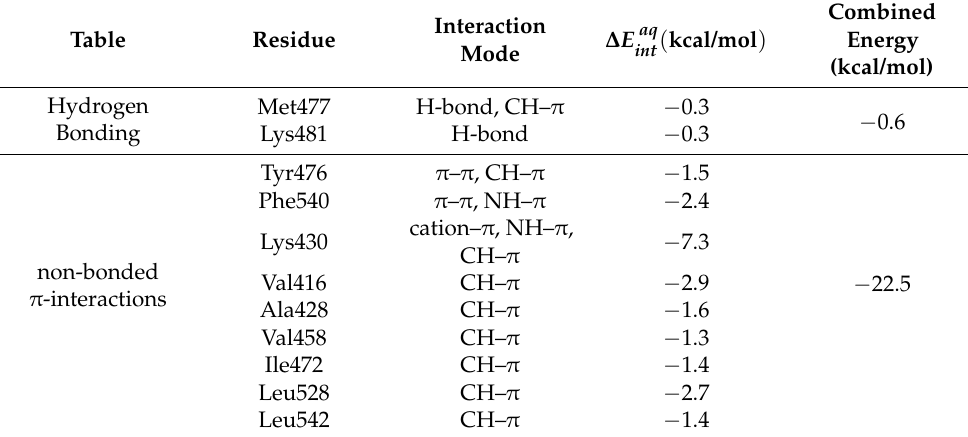
Table 5. Contributions of the different modes of intermolecular interactions to the binding affinity between ibrutinib and its interacting residues in tyrosine kinase